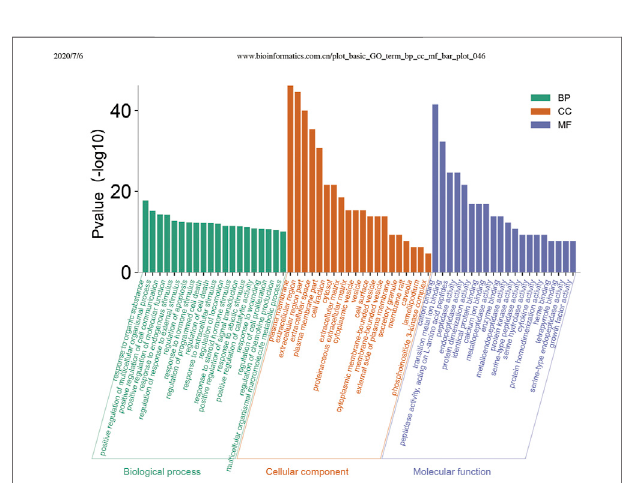
FIGURE 5| Enrichmentanalysisof the potential targets ofConvalescent Chinese prescription (CCP) against pulmonary fi brosis by R software 3.4.2 for the Gene Ontology database. Top 20 biological process (BP) terms, cellular component (CC) terms, and molecularfunction (MF) terms areshown as green bars, orange bars, and purple bars, respectively, according to “ p -value ( < 0.05), Bonferroni correction. ”